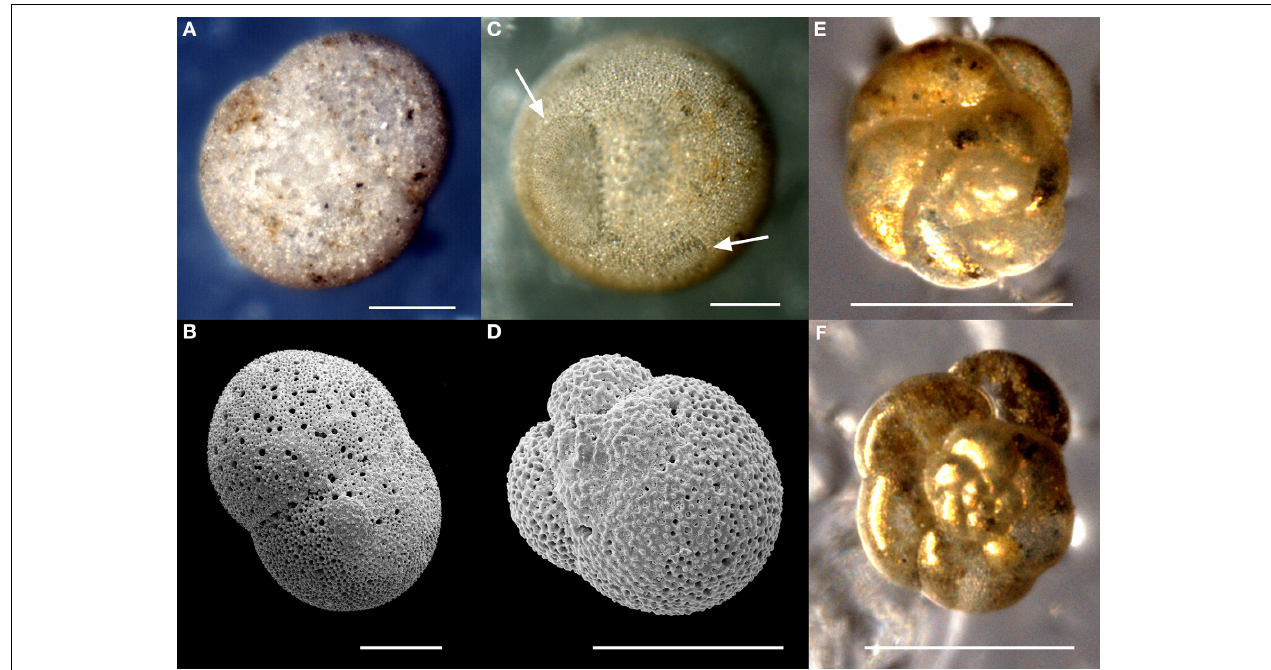
FIGURE 4 | Depiction of abnormal morphotypes. (A,B) Specimens of “ Biorbulina bilobata ,” an abnormal morphotype of Orbulina universa where the adult shell consists of two hemispheres that are joined in the middle, in light microscopic (A) and scanning electron microscopic (B) view. (C,D) Specimens of “ Orbulina suturalis ,” an abnormal morphotype of Orbulina universa where the juvenile trochospiral shell (compare Figure 2 ) is not completely enclosed by the adult spherical shell, in light microscopic